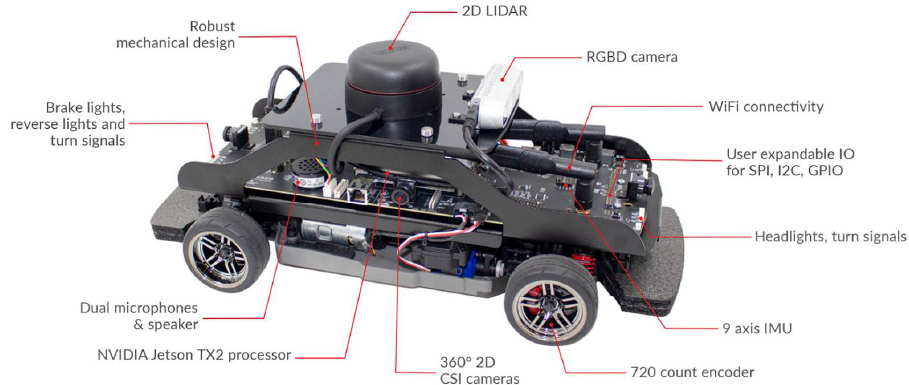
( b ) Average time Figure 9. RMSE and average feature matching time for change in resolution computed over 100 runs. On the whole, the KAZE method demonstrated minimal rotation errors compared to the other methods. However, it is the slowest in terms of computation time. The RMSE shown by the SIFT method was high, and it is also less reliable at times as it failed to estimate the rotation parameter between runs. The SURF and ORB methods were fast